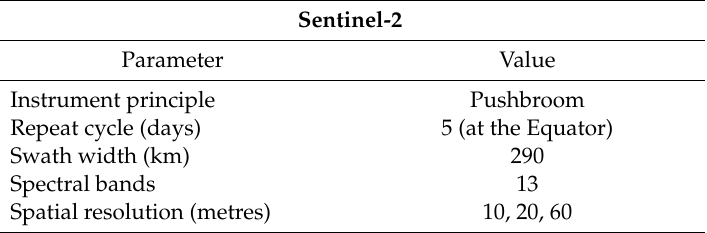
Table 2. Characteristics of the Sentinel-2